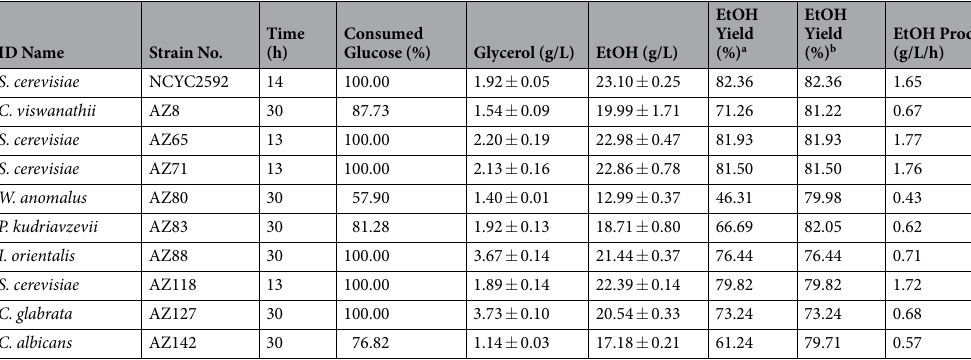
Table 1. HPLC analysis of fermentation samples of marine yeasts under screening for ethanol production using ROW-YPD medium. a Calculated as a percentage of the theoretical yield (0.51) based on the total glucose (55 g). b Calculated as a percentage of the theoretical yield (0.51) based on the utilised glucose.